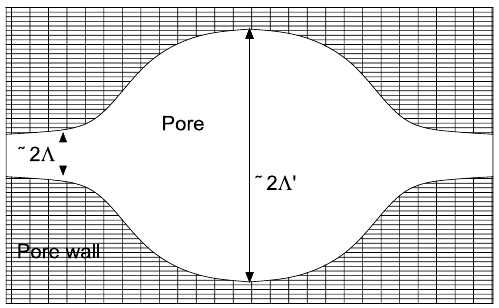
Figure 2. Schematic representation of thermal characteristic lengths.